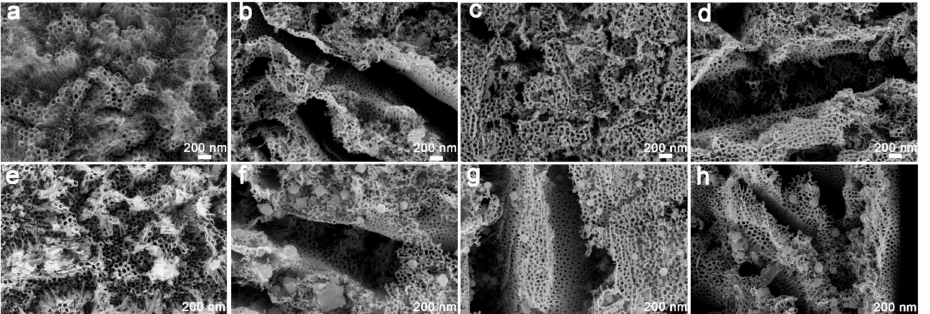
Figure 4. SEM images of different alloy-based nanotubes and annealed alloy-based nanotubes at 450 ◦ C in air, with all samples anodized at 30 V. ( a ) Ti-based nanotubes, ( b ) Ti10Nb-based nanotubes, ( c ) Ti10Nb0.5Fe-based nanotubes, ( d )Ti10Nb1Fe-based nanotubes, ( e – h ) are the annealed alloy-based nanotubes,